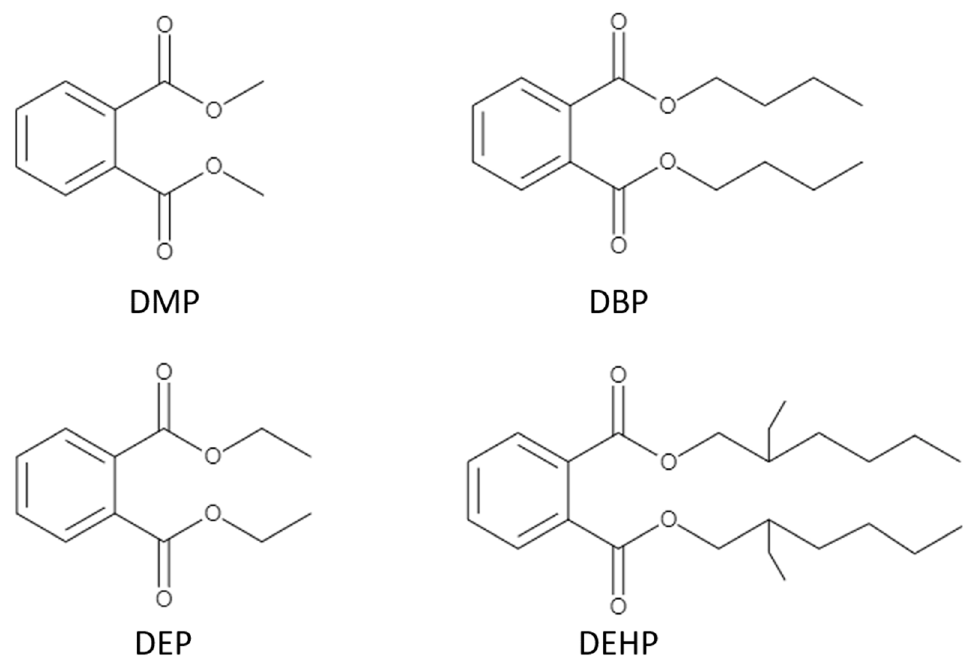
Figure 1. Chemical formula of the four PAEs analyzed.